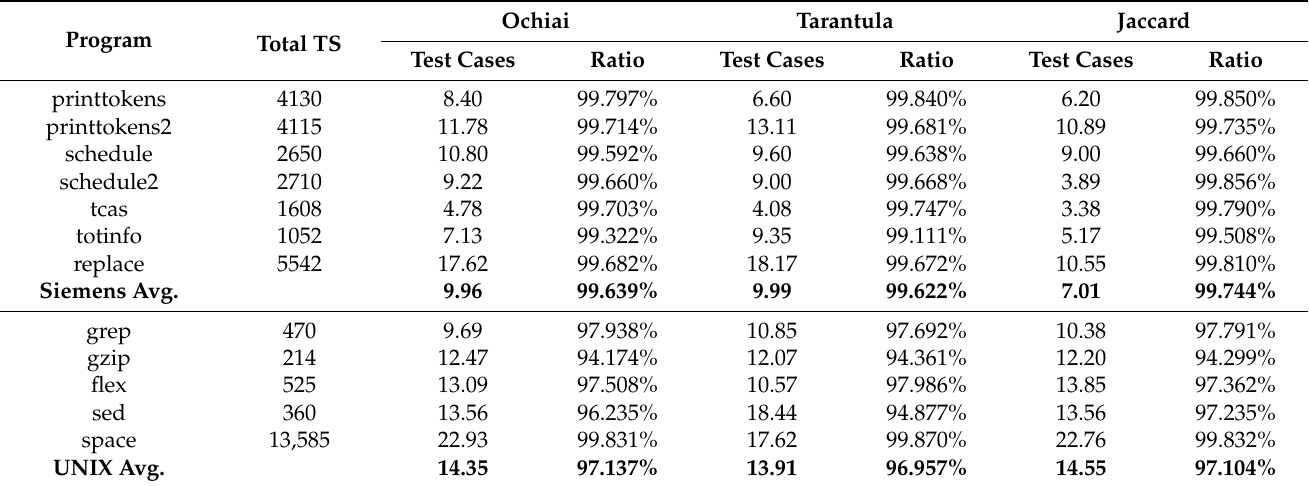
Table 4. Test cases and reduction ratio on subject